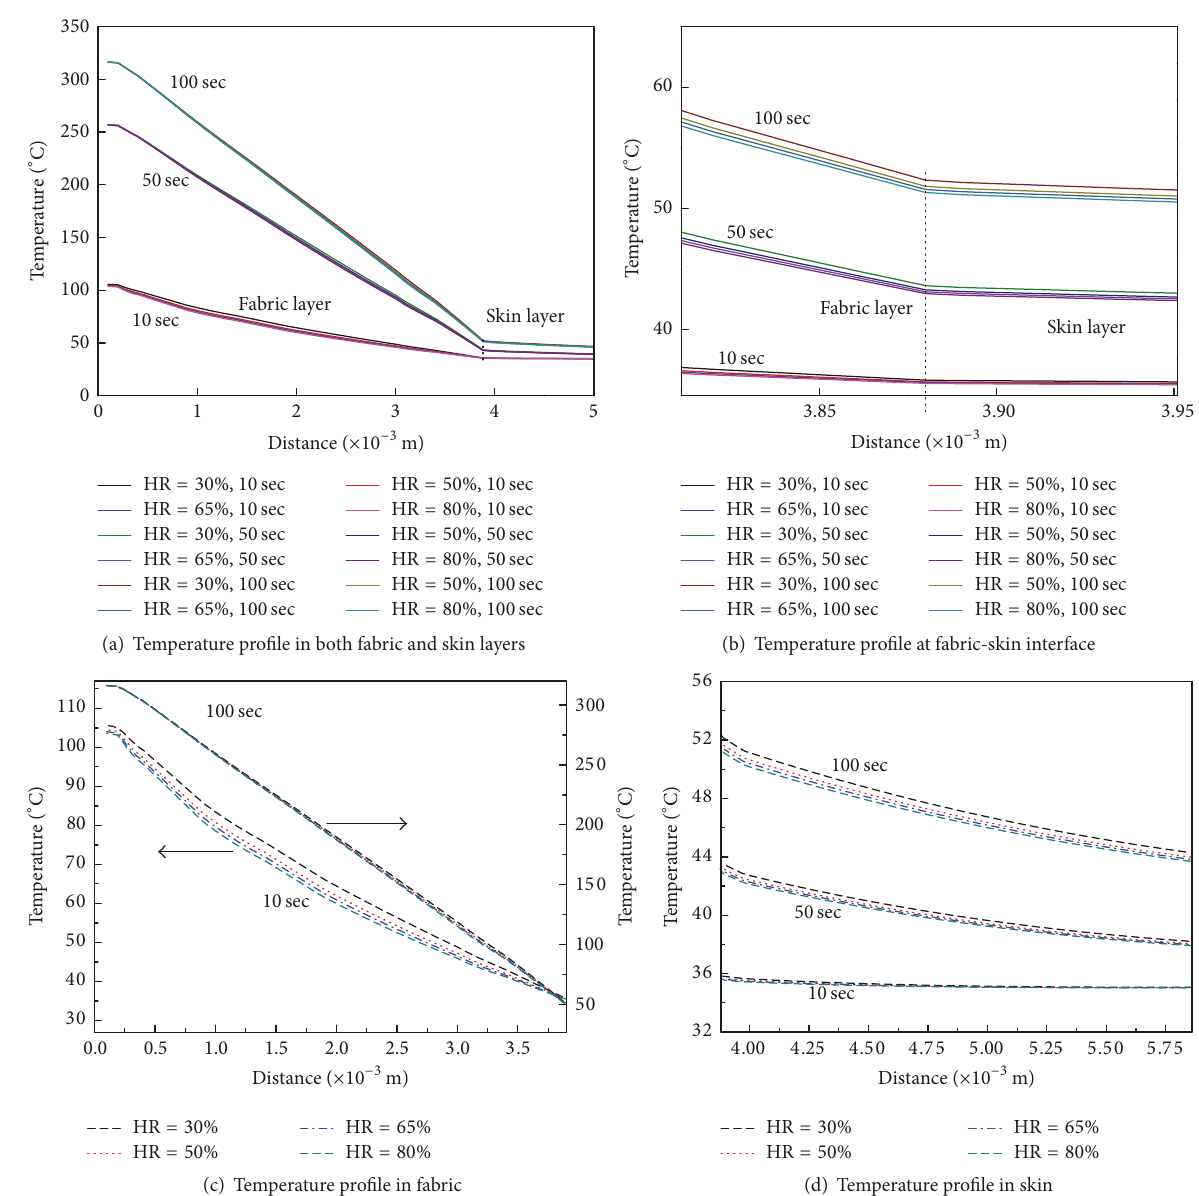
Figure 9: Temperature profiles in different layers at specific moments in